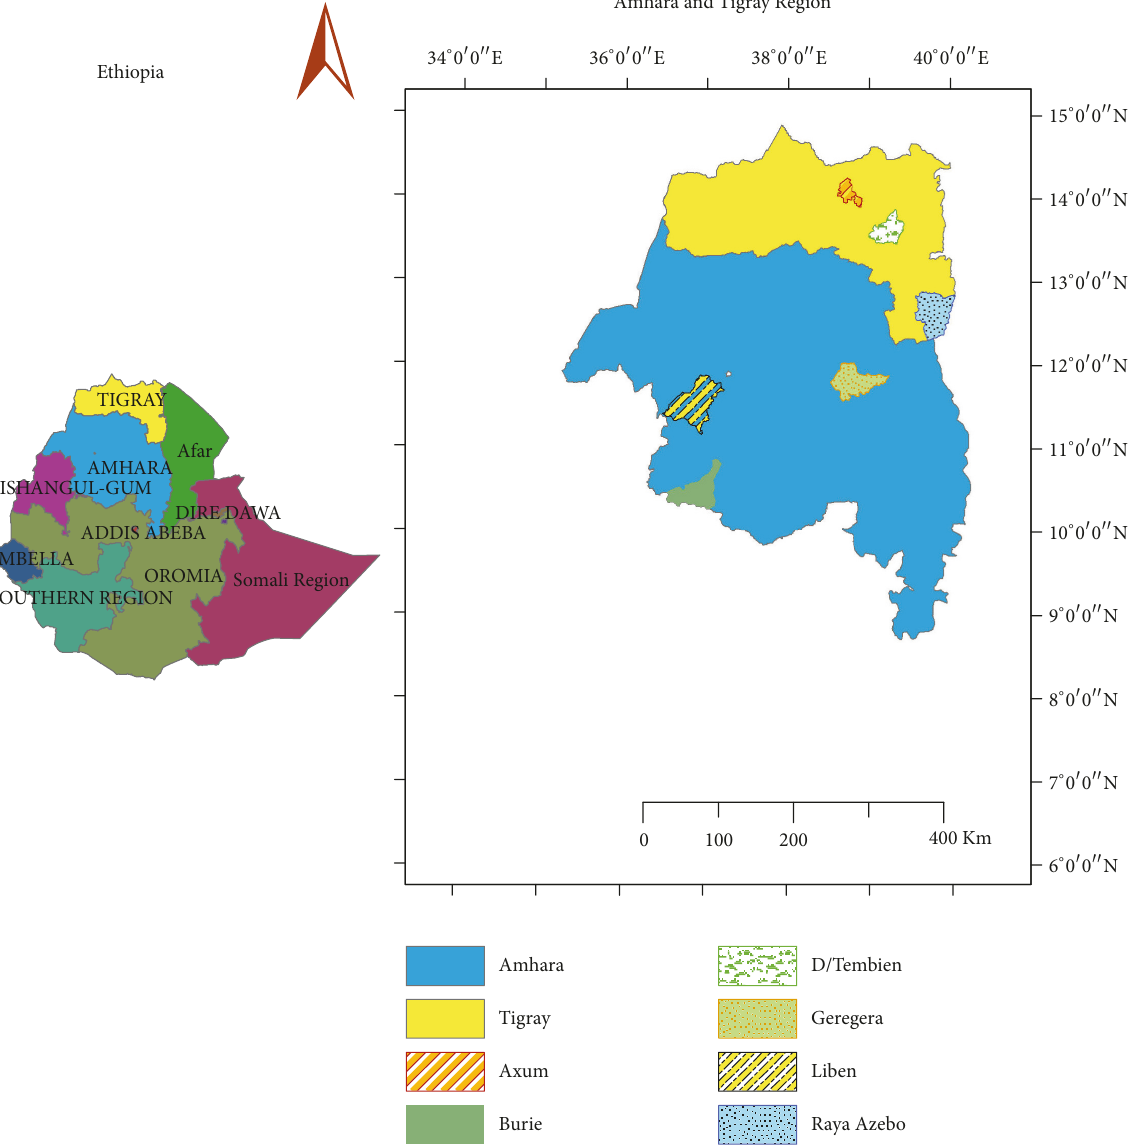
Figure 1: Location map of the study